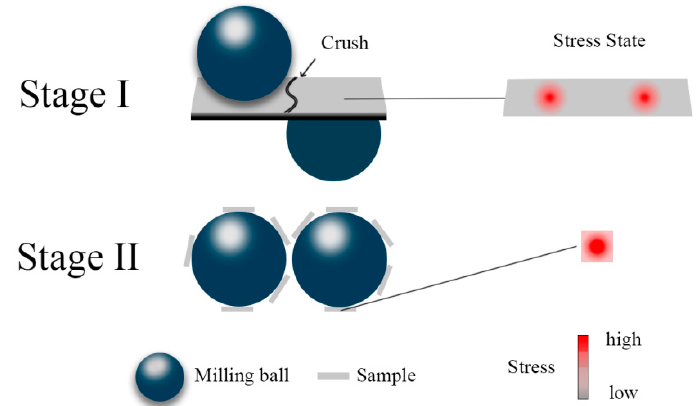
Figure 6. Schematic drawing of the different stress states of samples in Stage I and Stage II during milling.